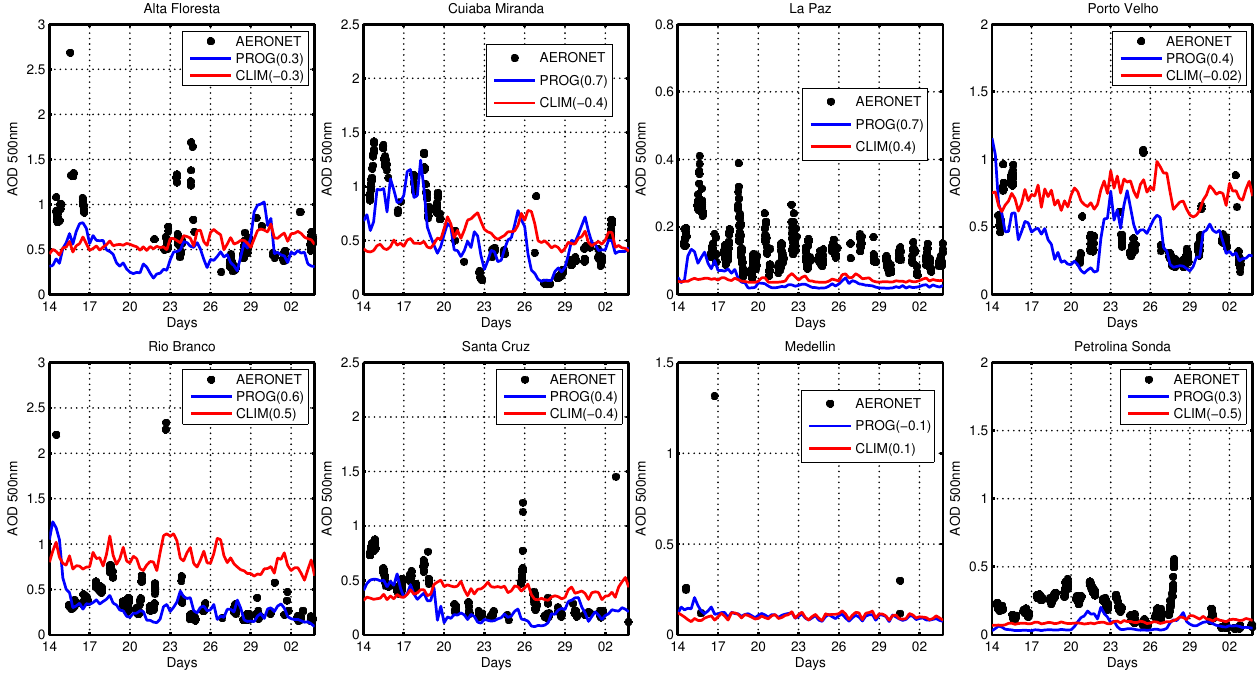
Figure 3. Time series comparison of AERONET (black *), PROG (blue line) and CLIM (red line) 550nm AOD at different locations. The correlation coefficients between AERONET and models are shown in parenthesis. Table 2. Mean modelled short-range weather changes with standard deviations (and standard error in brackets) due to BBA in box A (Fig. 1) over day 1 and day 2 of simulations. The net atmospheric divergence is denoted as ATM. NA denotes that data are not available. Radiation and weather parameters